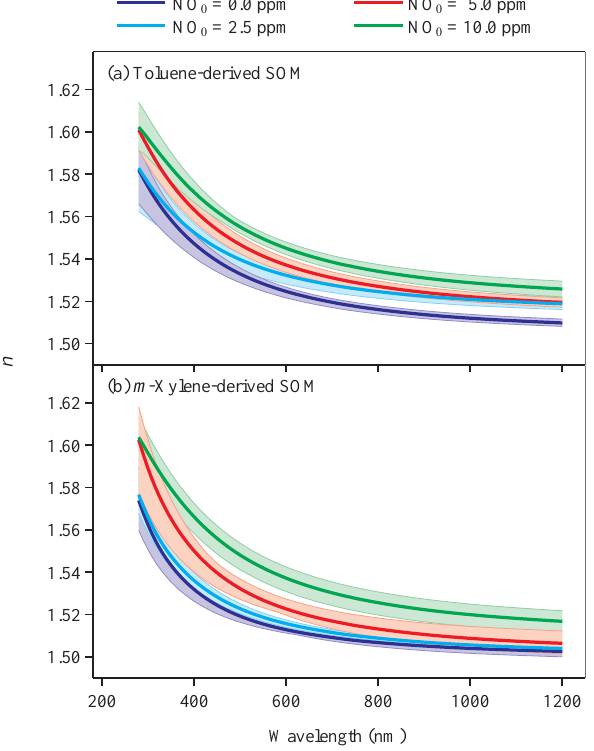
Figure 5. Real refractive indices n of (a) toluene-derived SOMs and (b) m -xylene-derived SOMs for several different initial NO concen- trations. The shaded regions represent confidence intervals of 10 to 90% for the ellipsometry